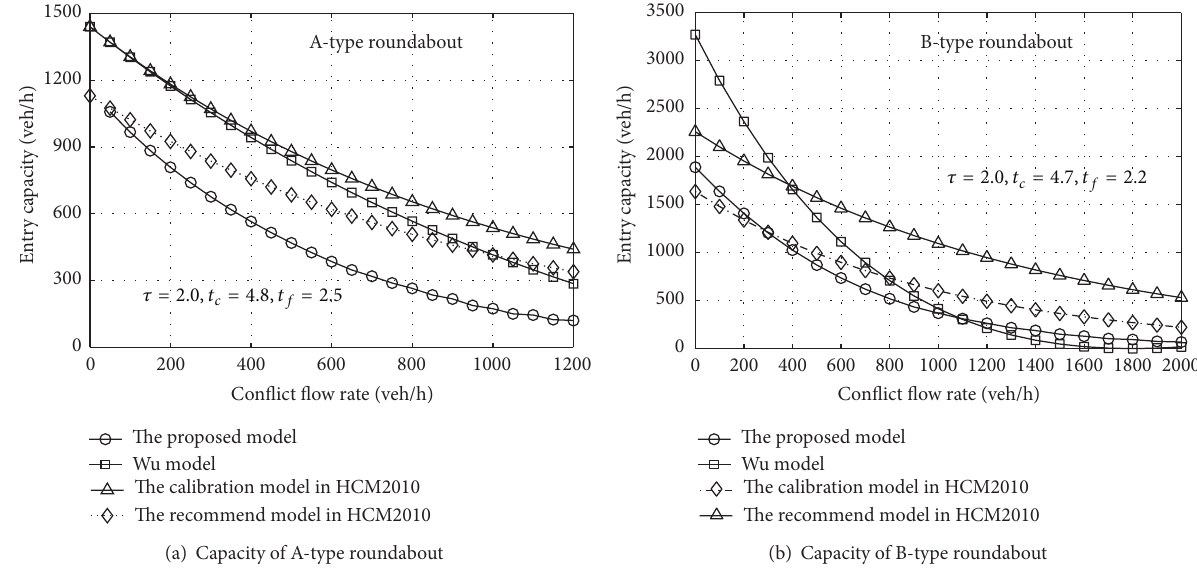
Figure 6: Comparison of capacity